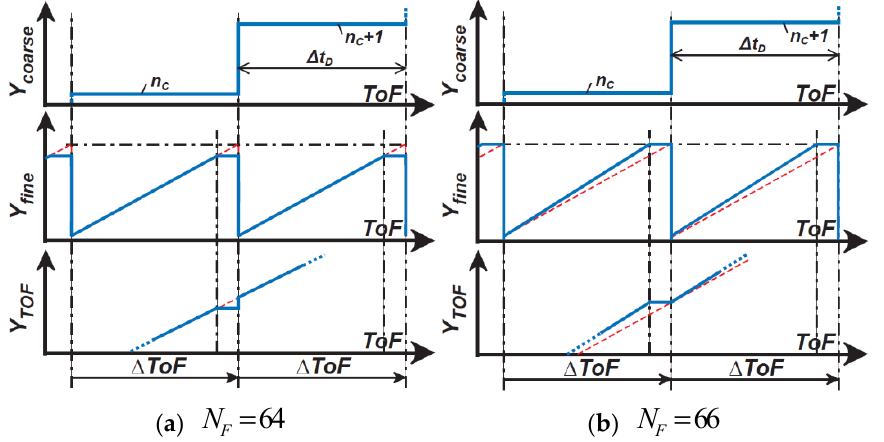
Y , and the combined output Y fine coarse